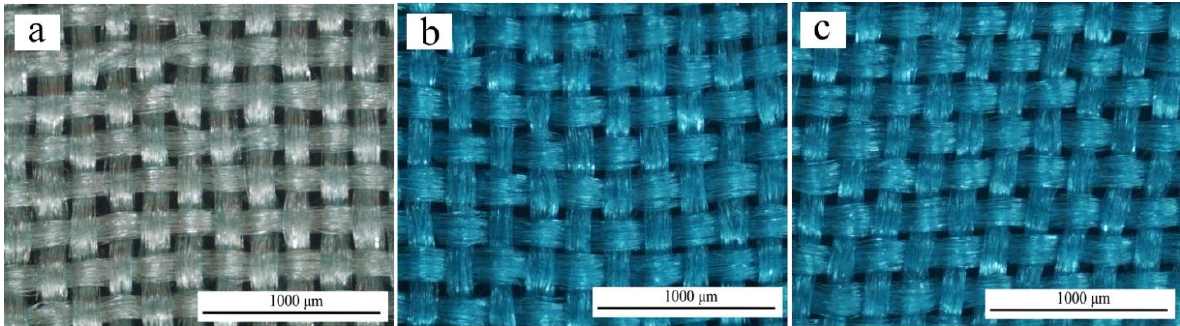
Figure 4. Optical microscopy images of Alcian blue stained untreated and surface modified fibroin fabrics. Magnification: ×40. ( a ) SFF; ( b ) SFF-1 and ( c )